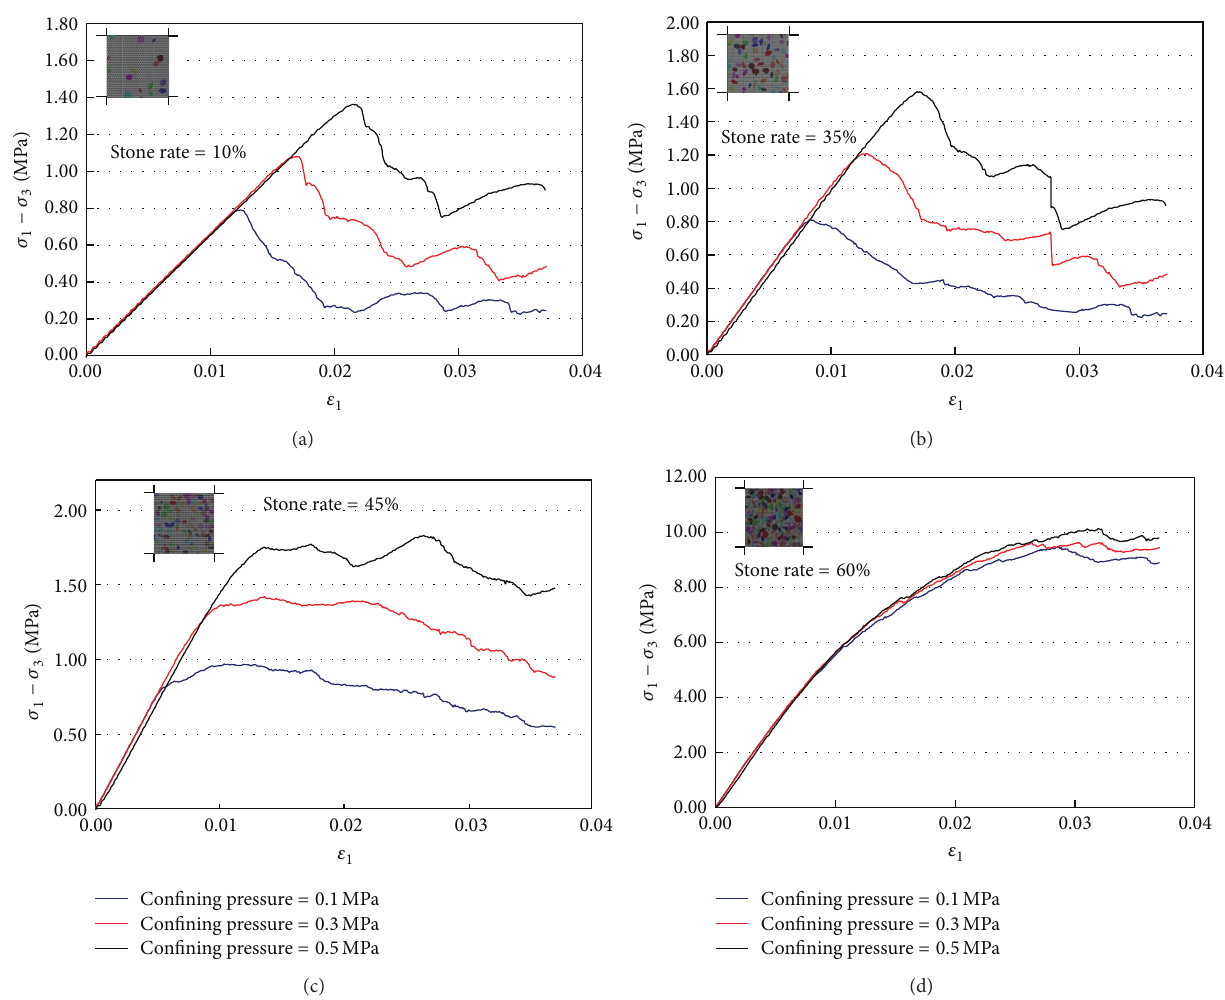
Figure 12: The biaxial compression curve at different confining pressures and stone block content. (a) Stone block content is 10%; (b) stone block content is 35%; (c) stone block content is 45%; and (d) stone block content is